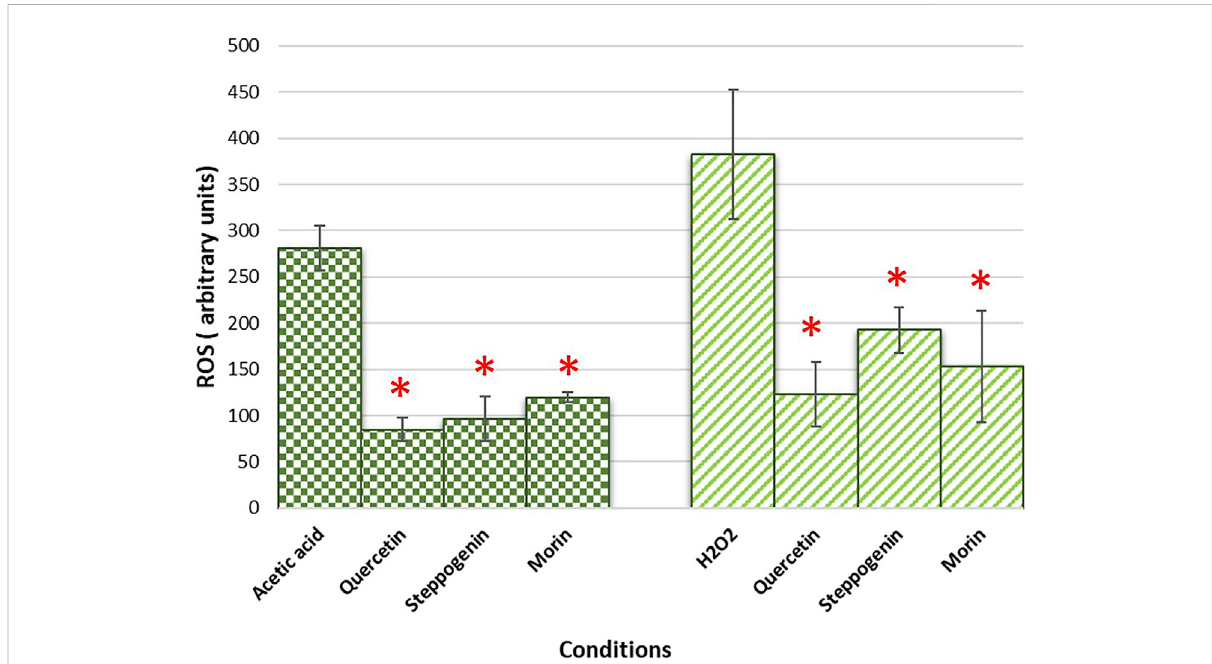
FIGURE 3 Quanti fi cation of intracellular reactive oxygen species accumulated during treatment with acetic acid or H 2 O 2 in the wild-type S. cerevisiae strain pretreated with quercetin, steppogenin or morin after 10 min of treatment with the indicated oxidant. At least two independent experiments were performed in triplicates with # p value < 0.05 when compared to DMSO-treated